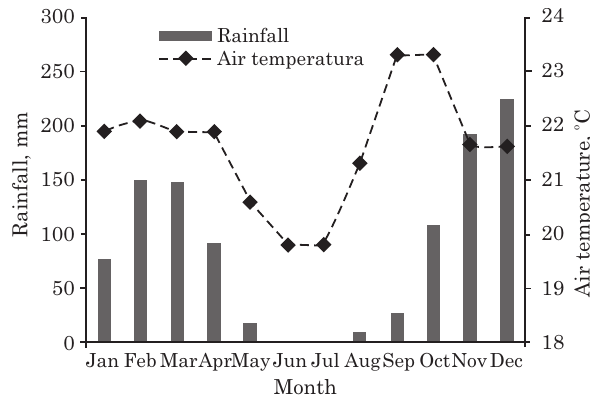
Figure 1. Mean monthly rainfall and mean air temperature from 2005 to 2013, in the experimental area of Embrapa Cerrados, Planaltina,